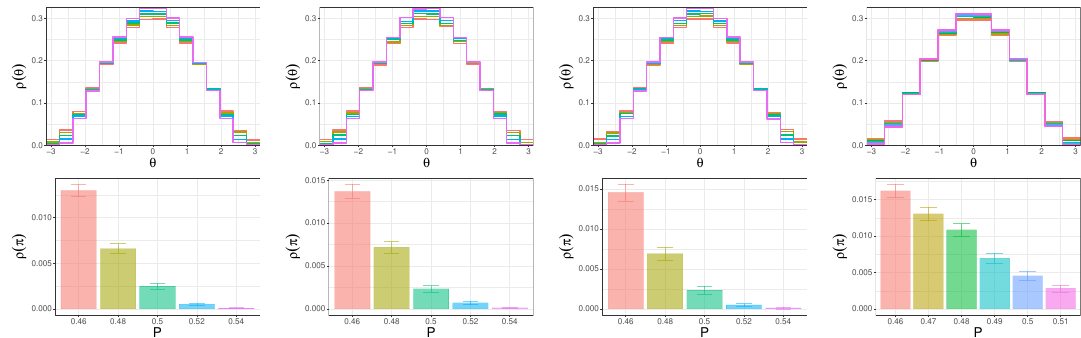
Figure 11. Distribution of the phases of the Polyakov line near the transition tempera- tures for the bosonic BMN model. From left to right, µ = 0 . 125 , 0 . 25 , 0 . 5 , 1 . 0 with T 0 . 8853 , 0 . 8864 , 0 . 8918 , 0 . 9134 , respectively. The matrix size and the lattice size are N = 64 and L = 24 , respectively. The gap opens at P ’ 0 . 5